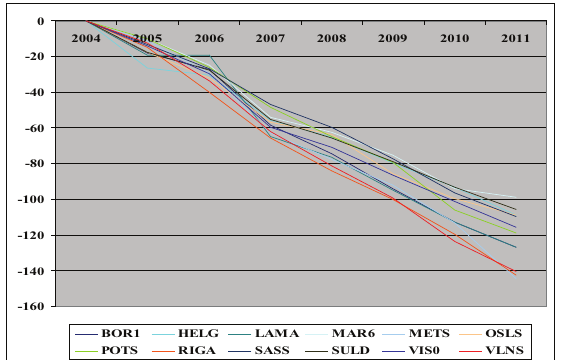
Fig. 6. The displacements of coordinate Z of the stations (mm)